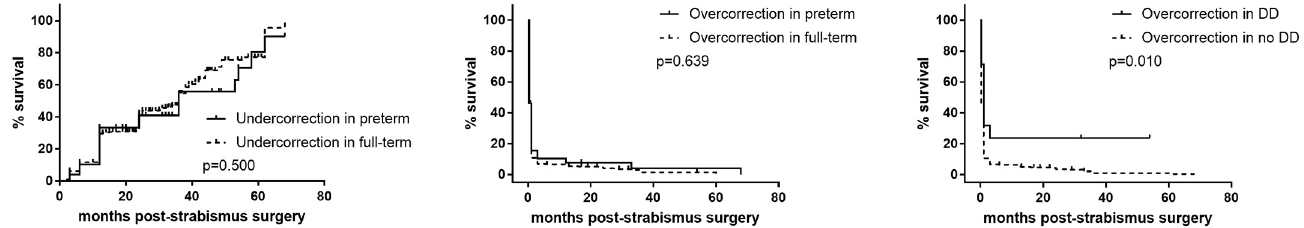
Fig 2. Survival curves for overall surgical recurrence and overcorrection results after surgery in exotropia. (Left) The recurrence rates are increased in both pre- and full-term children after surgery, and recurrence survival curves are similar between the pre- and full-term groups (p = 0.500). (Middle) The overcorrection survival curves are similar between the pre- and full-term groups (p = 0.639). (Right) Survival curves show a significantly larger cumulative overcorrection rate in patients with neurodevelopmental disabilities than in those without neurodevelopmental disabilities (p =